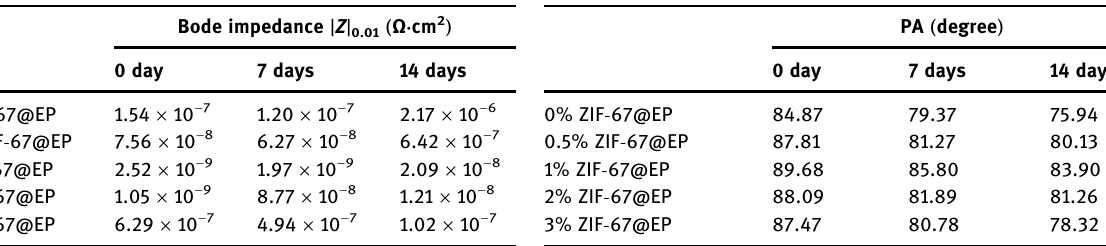
Table A4: Bode phase values of composite coatings at di ff